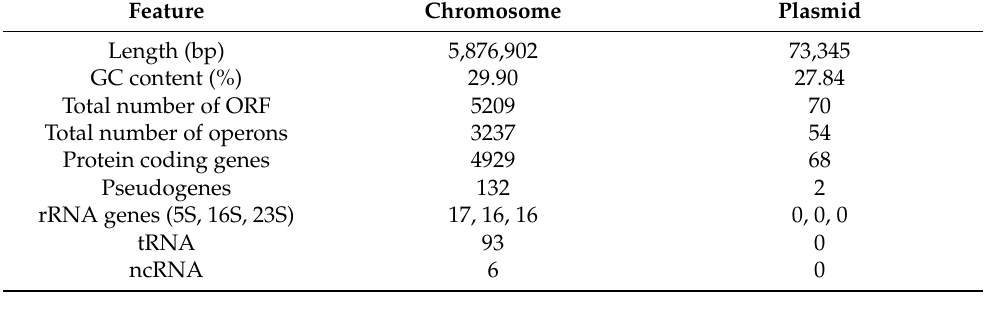
Table 1. Genome features of Clostridium beijerinckii DSM 791 T .